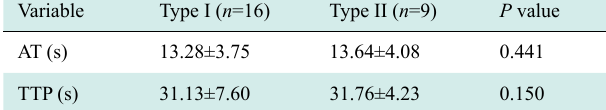
Table 4 Time-intensity curve parameters in PRCC types I and II